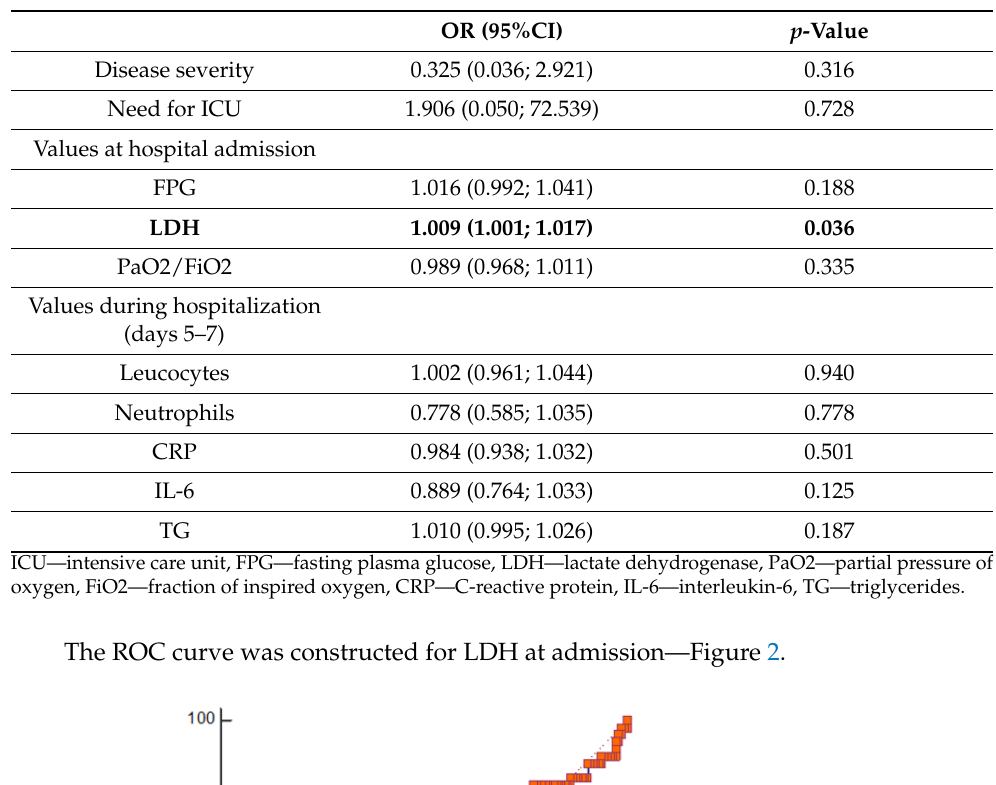
Table 5. Multivariable regression analysis of risk factors for new-onset diabetes in patients with COVID-19.